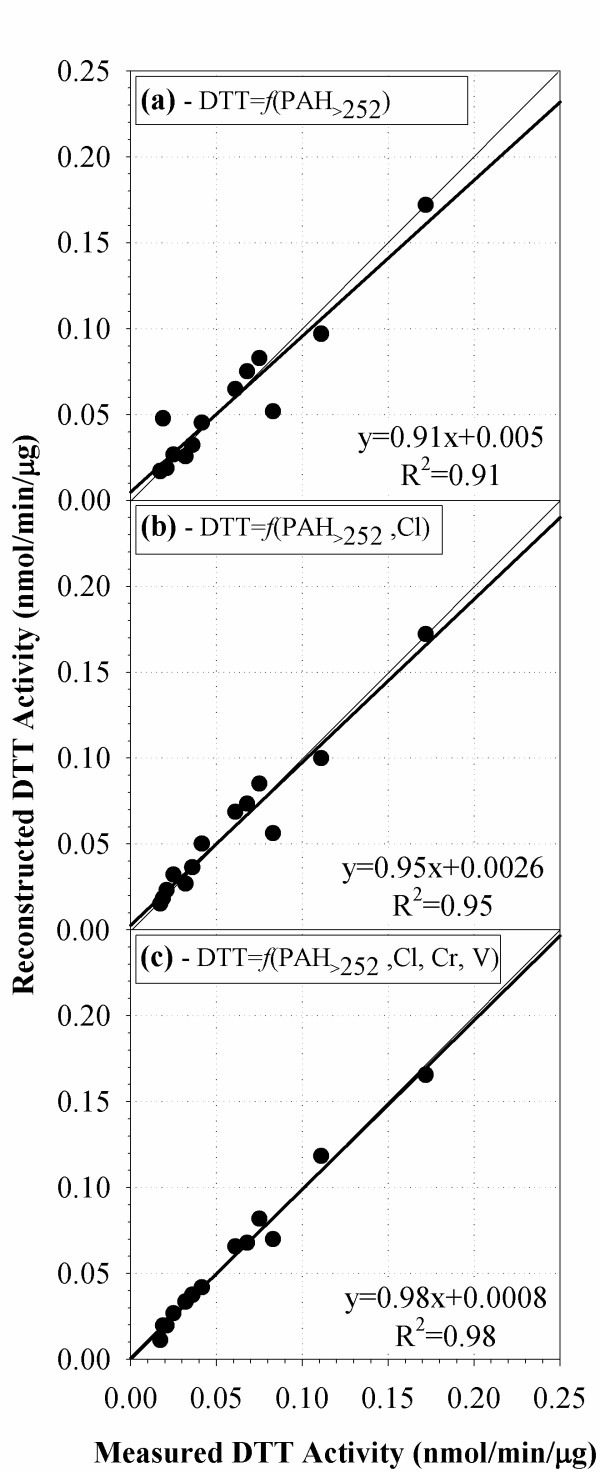
Correlation of measured and reconstructed DTT activity for samples in all size modes. (a) Correlation with PAH of molecular weight equal or greater than 252, (b) Correlation with PAH and Cl, (c) Correlation with PAH, Cl, Cr and V. The thin line is the chart diagonal representing the 1:1 line. The correlations demonstrate the strong correlation of DTT activity and PAH which may act as surrogates for other functional groups that have the capacity to reduce oxygen, such as quinones and aromatic nitro-PAHs. The correlation also improves and the intercept decreases when, gradually, Cl, Cr and V are introduced in the regression. The regression parameters that can be used to quantify the effects of each species on the DTT activity are given in Table 4.